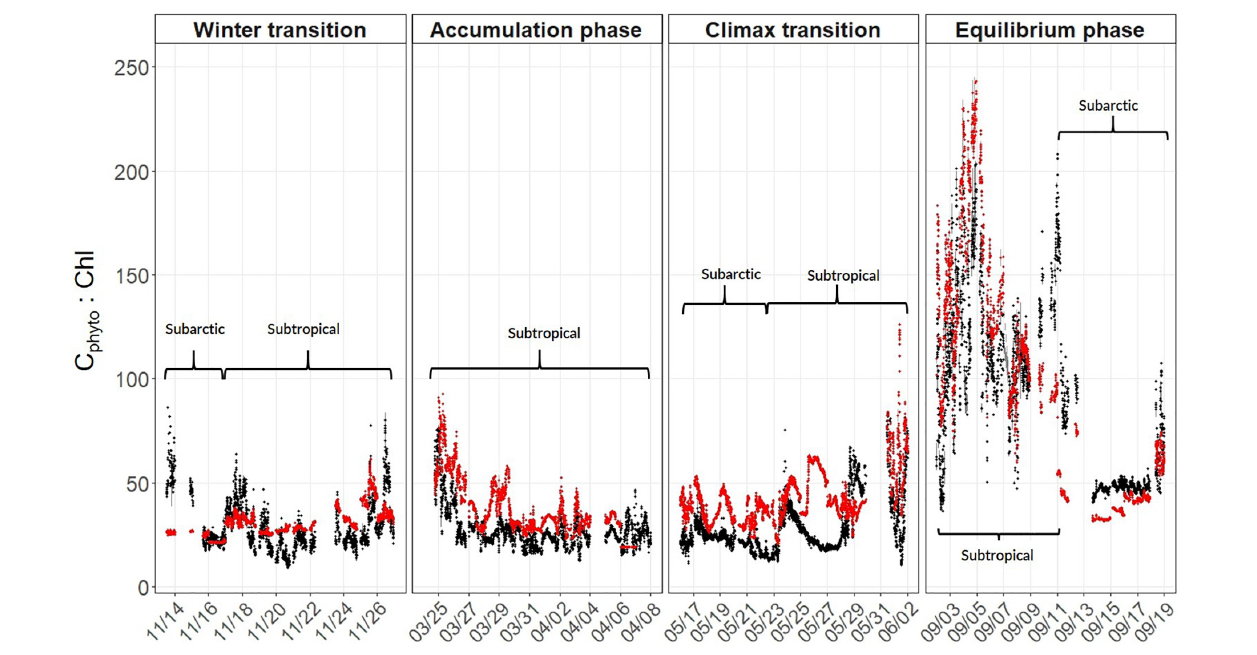
FIGURE 4 | Estimates of the phytoplankton carbon-to-chlorophyll ratio ( θ ) calculated using PaM (red circles) and measured using underway optics (black circles). Values were binned to 1-minute resolution and plotted along the NAAMES science-intensive transect. Phases of the annual cycle are shown at the top and within-panel brackets distinguish geographical regions (see section “Spatio-Temporal Variability in Phytoplankton Carbon and Chlorophyll” for information).